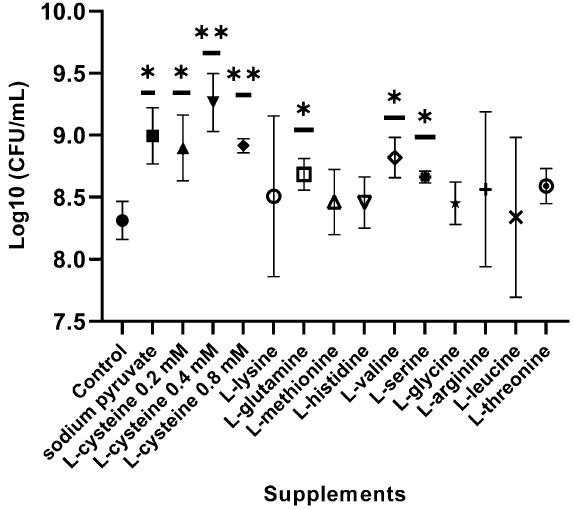
Figure 3. Effect of sodium pyruvate and amino acids on the growth of C. hepaticus HV10 T in Brucella broth (control). Cultures were inoculated with 10 6 CFU/ml and incubated for 48 h at 37 °C. P-values were calculated